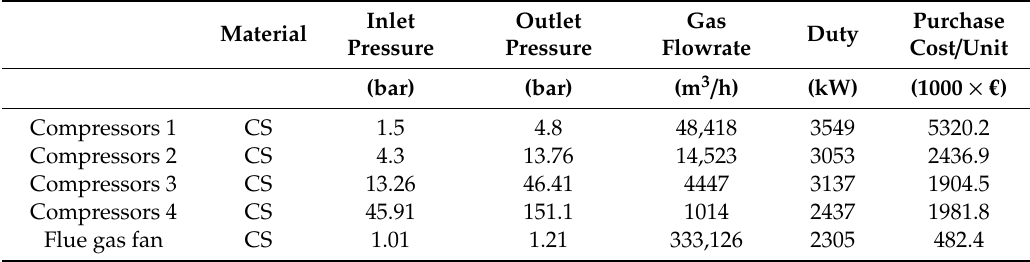
Table A5. Compressors and flue gas fan dimensions and purchase costs from Aspen In-Plant Cost Estimator V11 (purchased cost year: